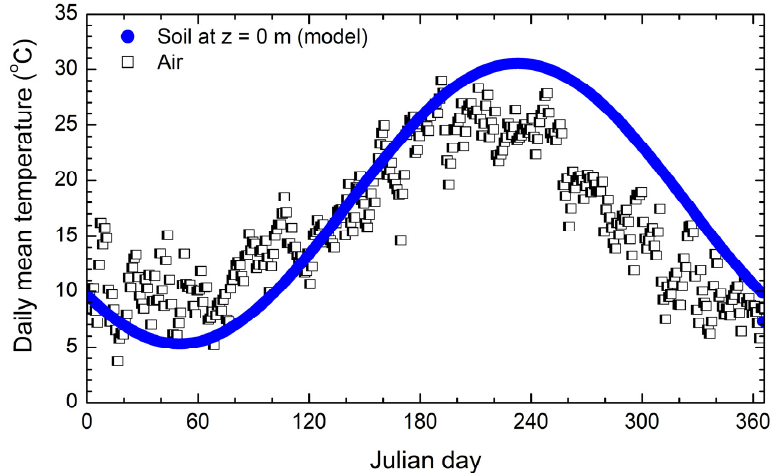
Figure 5. Daily mean air temperature (measured) and surface soil temperature (calculated from Equation (6)) for year 2017.